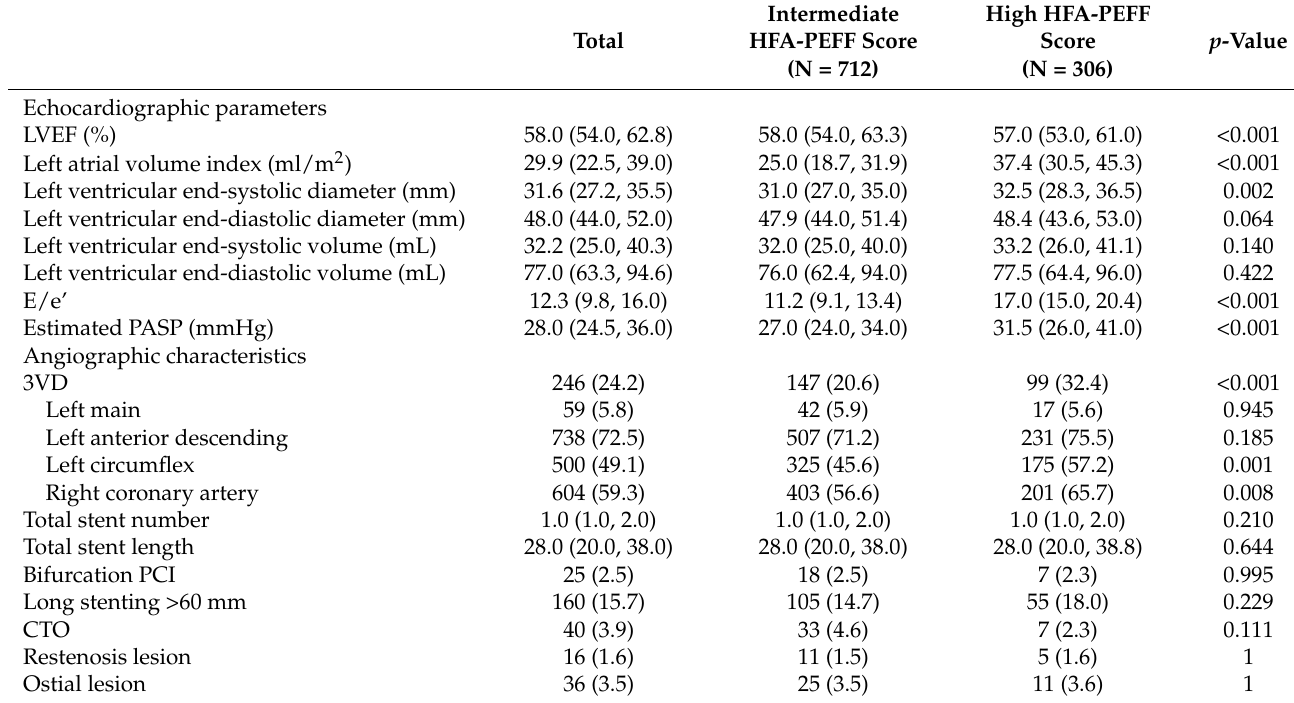
Table 2. Baseline echocardiographic and angiographic characteristics.